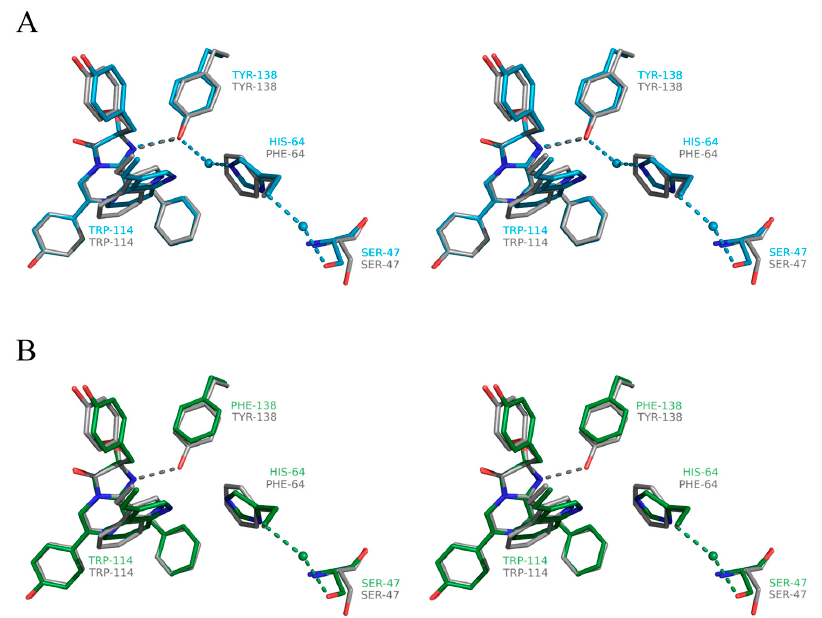
Figure 6. Stereoview of the superimposition of 2-hydroperoxycoelenterazine molecules with the residues residing near their N1 atoms: ( A ) OL_H64F mutant (gray) vs. wild-type obelin (cyan) and ( B ) OL_H64F mutant (gray) vs. OL_Y138F mutant (green). Hydrogen bonds are shown as dashed lines. Oxygen and nitrogen atoms are colored with red and blue,